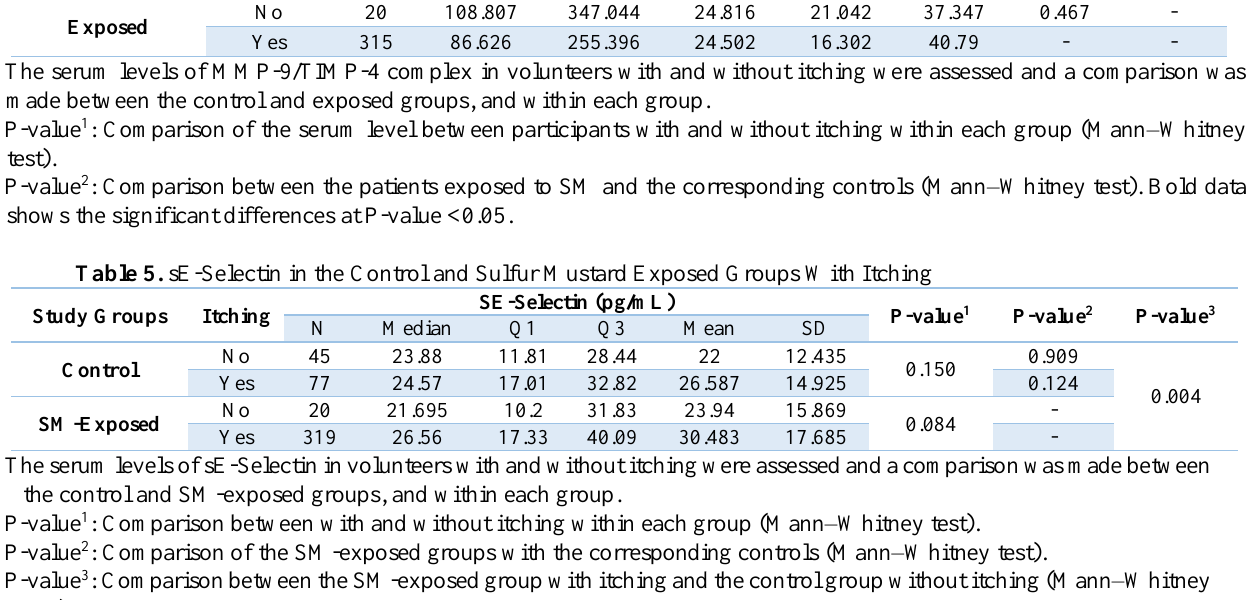
Table 4. MMP-9/TIMP-4 complex (Serum) in control and exposed groups With itching MMP-9/TIMP-4 Serum (ng/mL) Study Groups Itching N Mean SD Median No 44 Control No Exposed Yes The serum levels of MMP-9/TIMP-4 complex in volunteers with and without itching were assessed and a comparison was made between the control and exposed groups, and within each group.